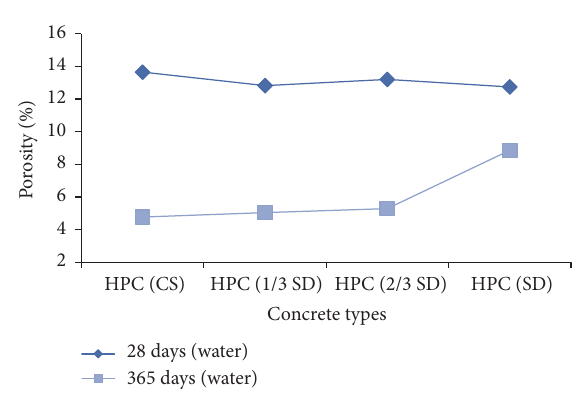
Figure 7: Absorption coefficients by capillarity of